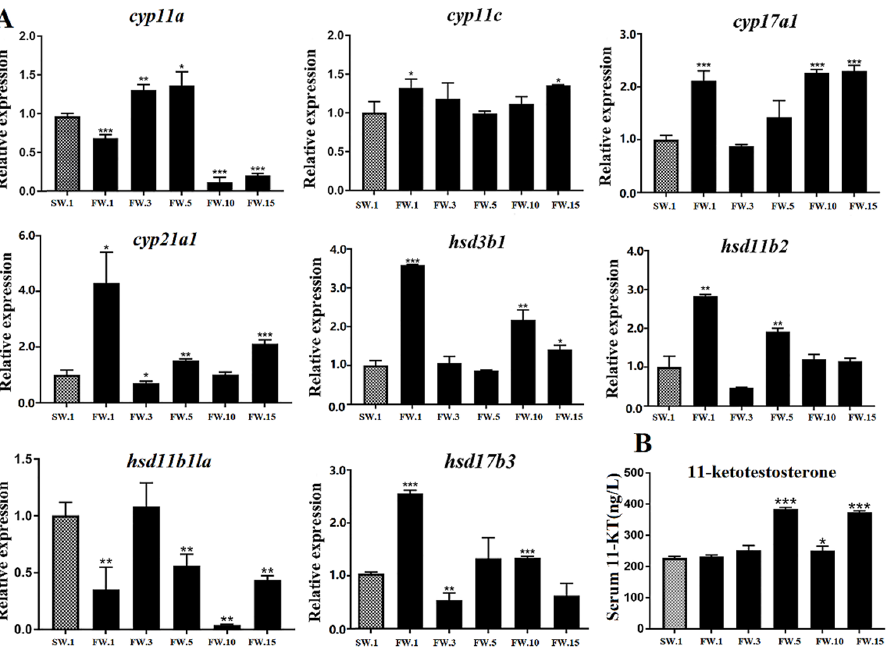
Figure 6. Synthesis regulation of 11-KT in the testes of male L. maculatus in response to salinity change. ( A ) Expression of candidate steroidogenic genes in the testes of male L. maculatus . ( B ) Serum 11-KT levels in male L. maculatus after the freshwater acclimation. * represents p < 0.05; ** represents p < 0.01; *** represents p < 0.001.